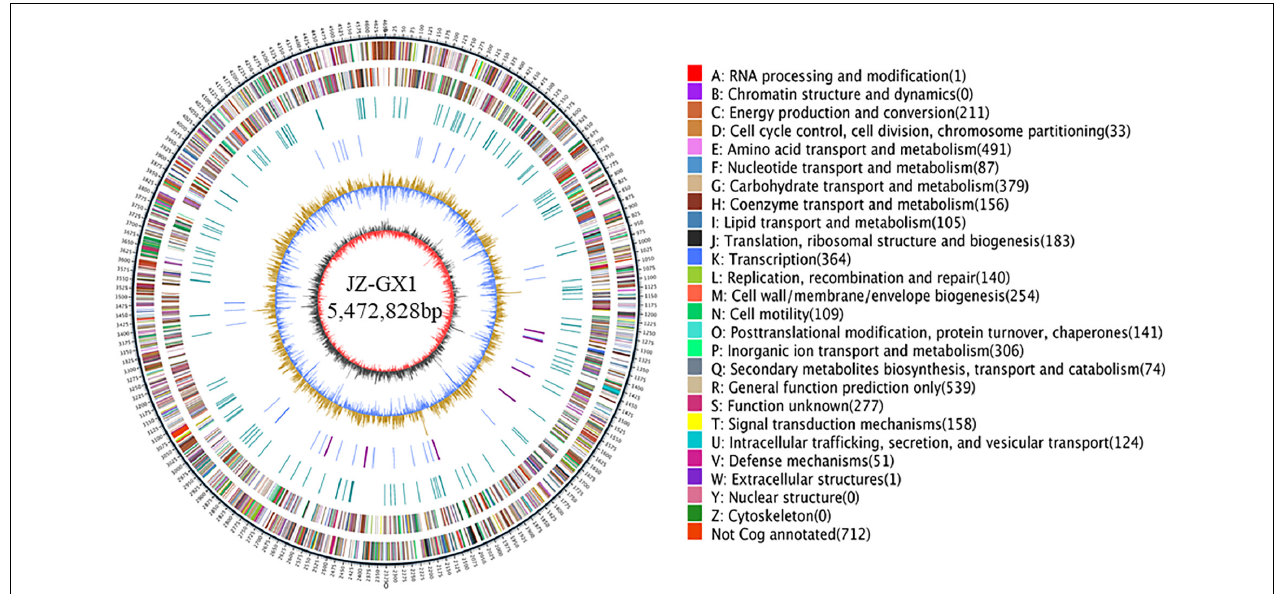
FIGURE 1 | The whole genome of Rahnella victoriana JZ-GX1. The genome map is composed of seven circles. From the outer circle to inner circle, each circle displays information regarding the genome of (1) forward CDS, (2) reverse CDS, (3) forward COG function classification, (4) reverse COG function classification, (5) nomenclature and locations of predictive secondary metabolite clusters, (6) G + C content, and (7) GC skew.